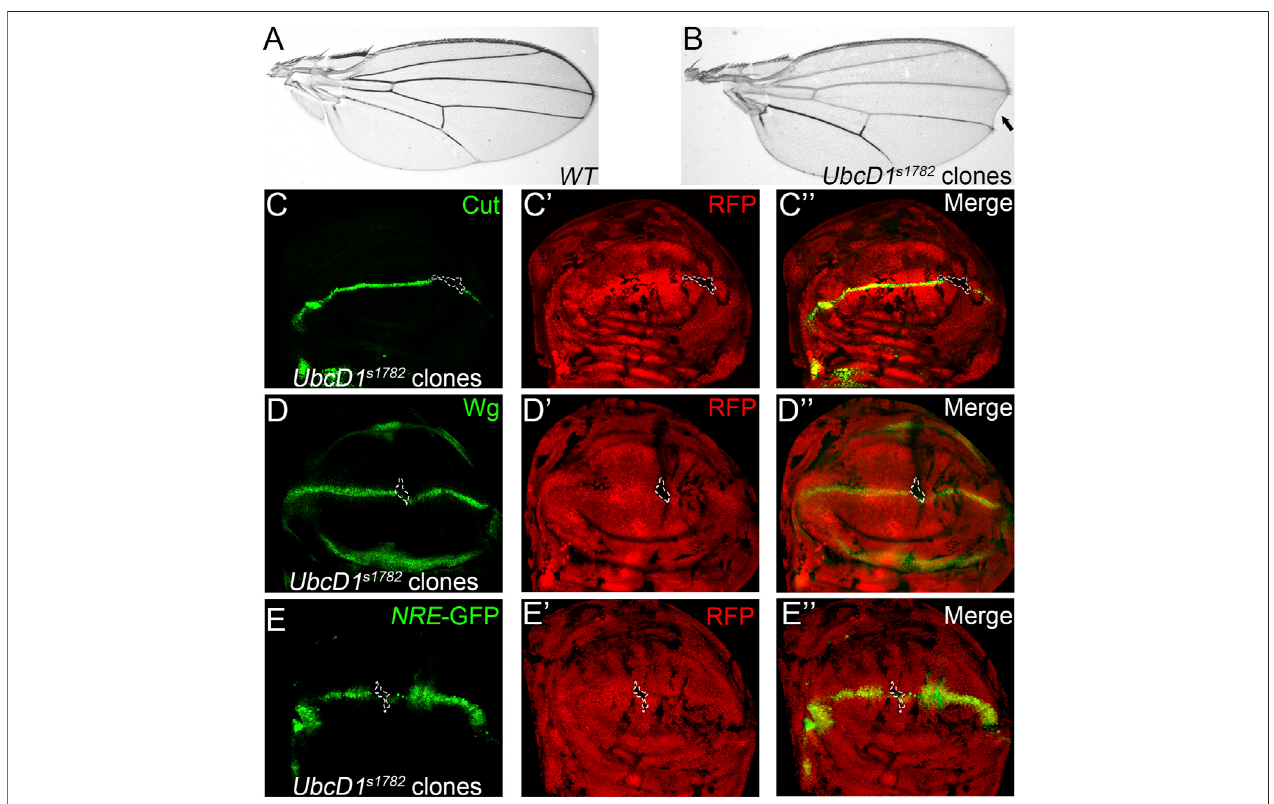
FIGURE1| UbcD1 s1782 showsphenotypesthatresembleNotchLOFin Drosophila wing. (A – B) Wingoftheparental Ubx-Flp;FRT82B,Ubi-RFP stockisshownas wildtype control (A) . Wing margin loss (black arrow) isobserved in fl y wingsbearing UbcD1 s1782 homozygous clones (B) . (C – E) Expression ofNotch signaling targets Cut (C) , Wg (D) and the reporter NRE -GFP (E) are abolished in UbcD1 s1782 homozygous mutant clones. Mutant clones are marked by absence ofRFP. Representative mutant clones are circled by dashed